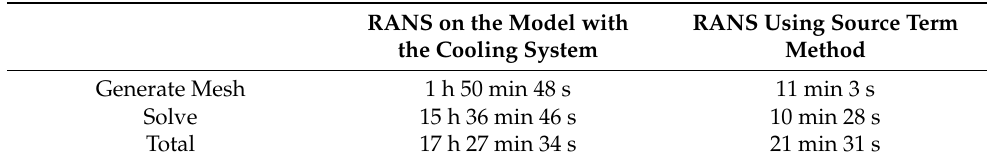
Table 3. Comparison of the computational cost for the base model.